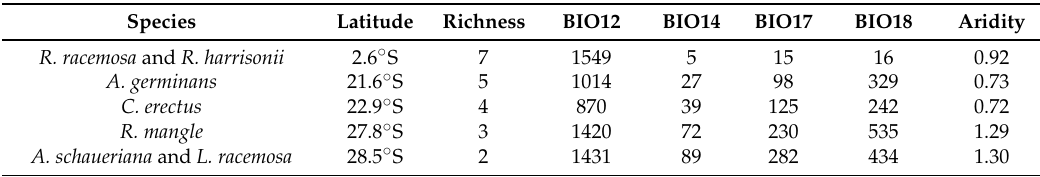
Table 4. An overview precipitation derivate and aridity according to punctual information at latitudinal species limits and their species richness for each limit. Species Latitude Richness BIO12 BIO14 BIO17 BIO18 Aridity R. racemosa and R.